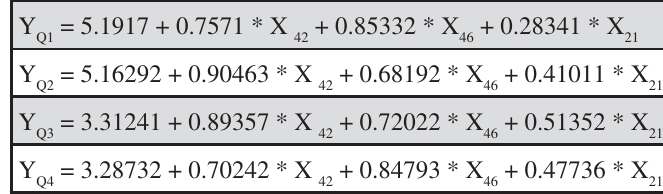
Figure 7- The optimized equations using genetic algorithm Table 4- Correct estimations, overestimations and underestimations in percentages Canines premolars group